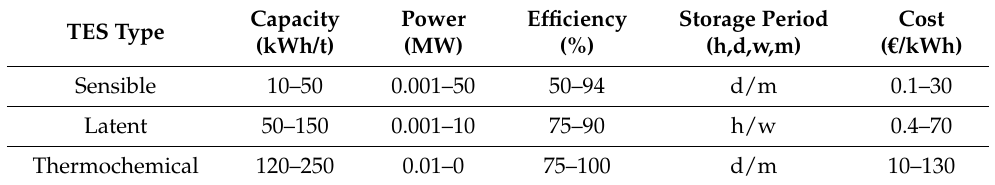
Table 1. Typical characteristics of TES